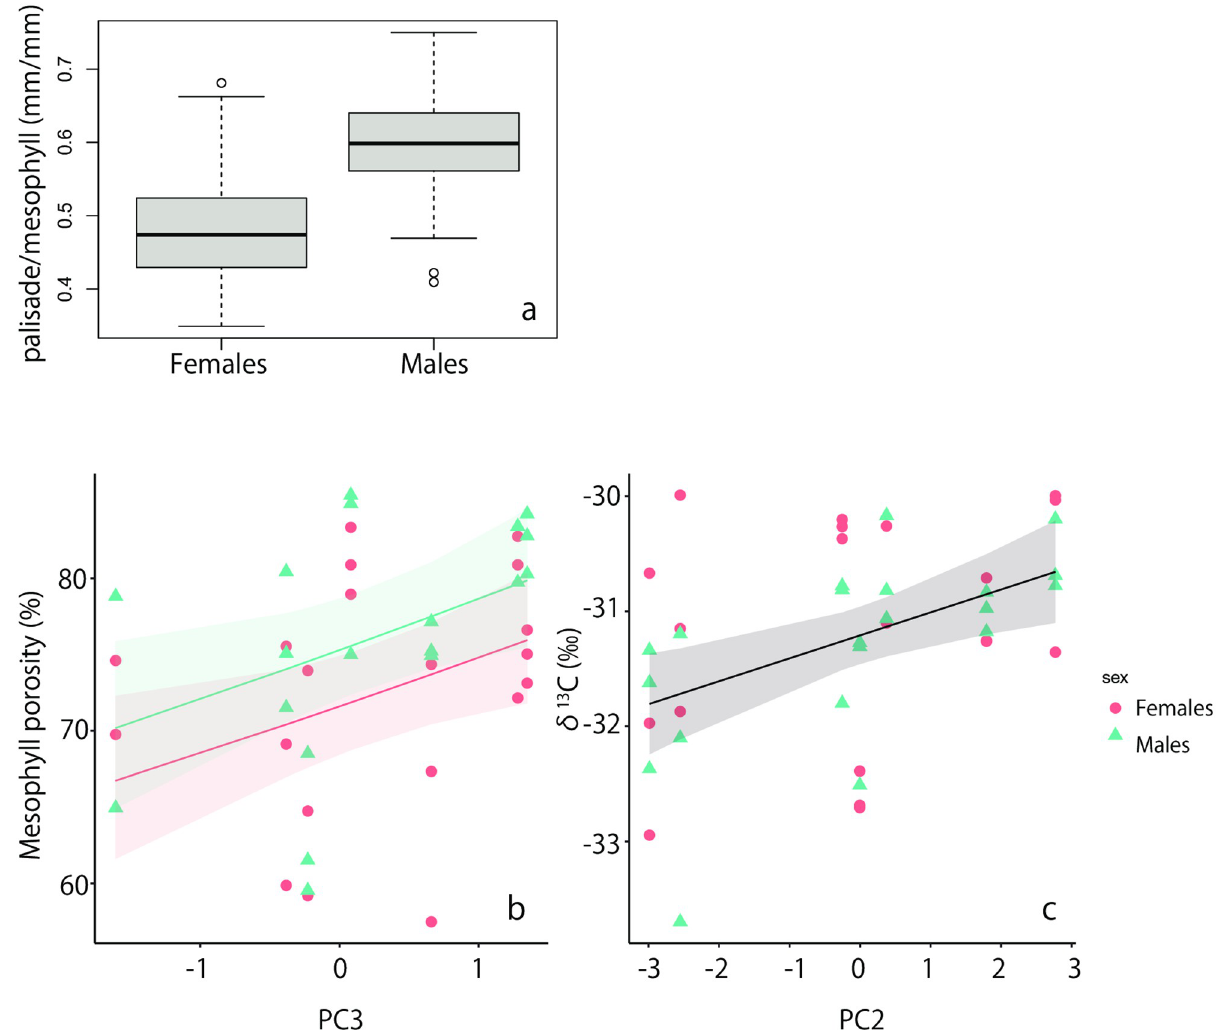
Fig 4. Relationship between thickness of palisade layer per mesophyll layer and sexes (a), mesophyll porosity, PC3, and sexes (b), and δ 13 C values and PC2 (c). The line and shading indicate the mean and the 95% confidence intervals of GLMs. Red circles and lines: females, blue triangles, lines: males.